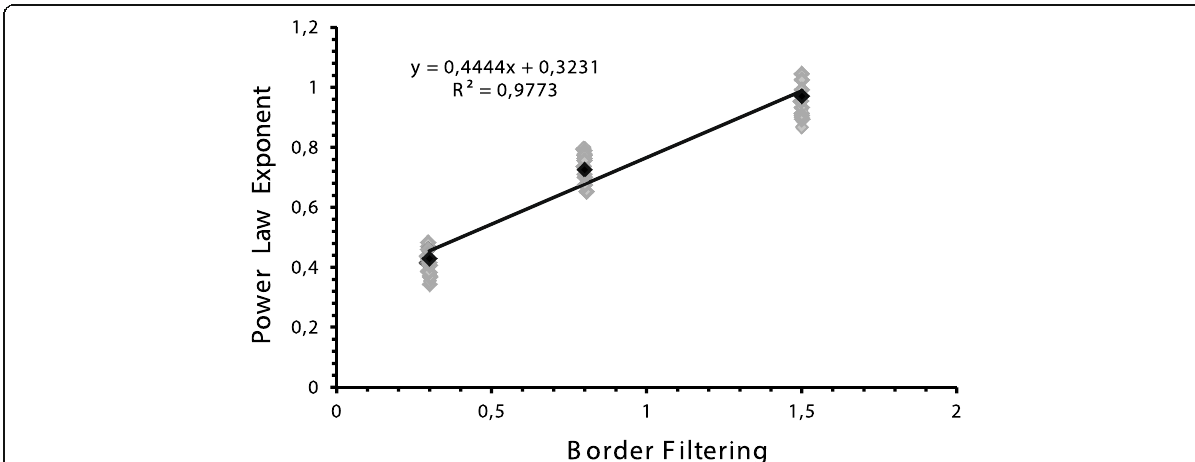
Fig. 3 A linear increasing on the power law ’ s exponent, as a function of the amount of the edges ’ filtering suggests a proportional subjective impression of the brightness with the increasing of the edge